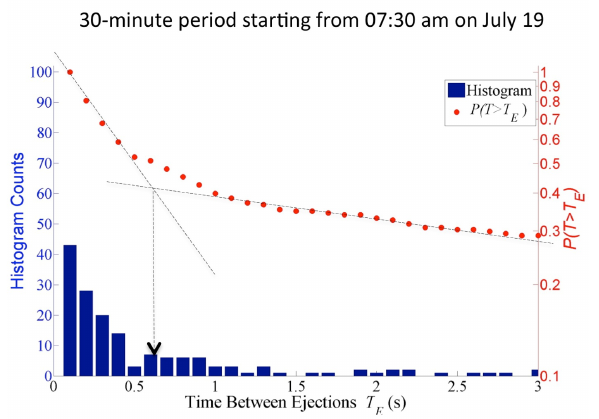
Figure A2 . Sample histogram (left axis) and cumulative probability distribution (right 857 Fig. A2. Sample histogram (left axis) and cumulative probability axis) of time between ejections ( T E (s)) for a single 30-­‐minute time period (07: 30 LT on 19 858 distribution (right axis) of time between ejections ( T E (s)) for a sin- July 2009). The time frequency parameter, τ , can be estimated by the minimum in the 859 gle 30-min period (07:30LT on 19 July 2009). τ , the maximum time between ejections of the same burst event, can be estimated by histogram or the intersections of the two asymptotic lines in the plot of the cumulative 860 the minimum in the histogram or the intersections of the two asymp- probability distribution on a logarithmic scale against T E (Luchik and Tiederman, 1987; 861 totic lines in the plot of the cumulative probability distribution on a Tiederman, 1989). 862 logarithmic scale against T E (Luchik and Tiederman, 1987; Tieder- man, 1989).